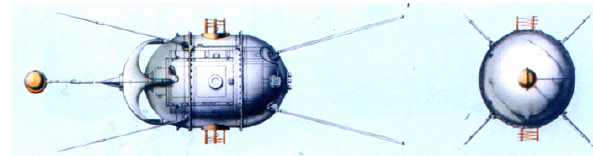
Figure 1. External view of the DS-MG type spacecraft (Kosmos-26 and Kosmos-49), 1964 (Konyukhov, 2000).